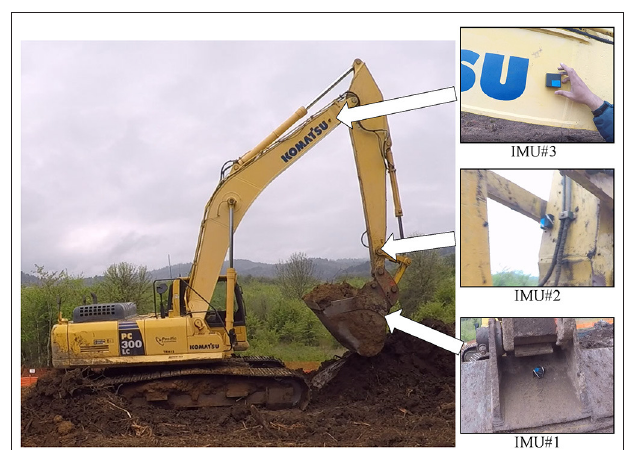
FIGURE 5 | Location of IMUs on